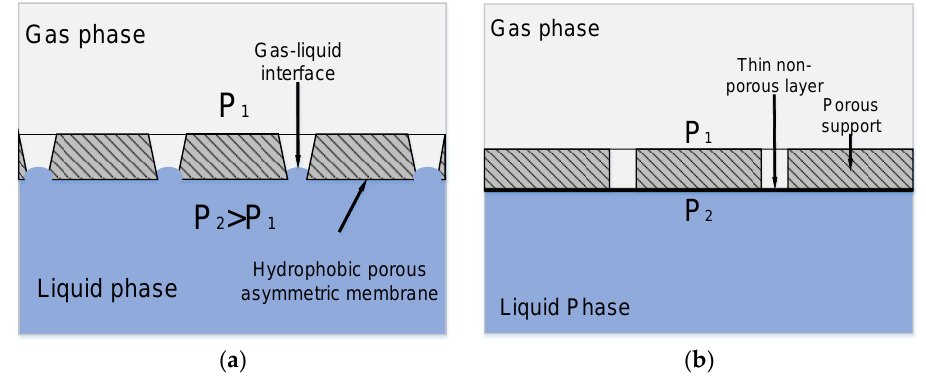
Figure 3. Principle of mass transfer in a membrane contactor based on: ( a ) Asymmetric hydrophobic porous membrane; and, ( b ) Asymmetric composite membrane with a thin nonporous layer.